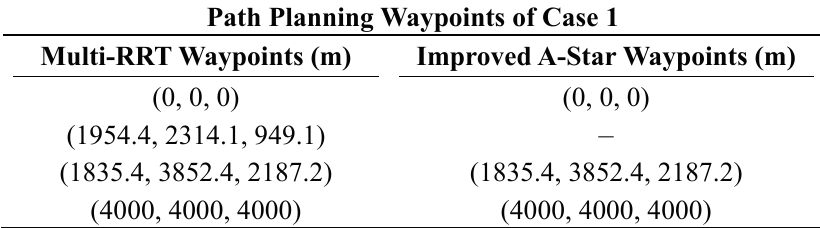
Table 1. Waypoints of the paths generated by the multi-RRT (rapidly-exploring random tree) and improved A-star algorithms.